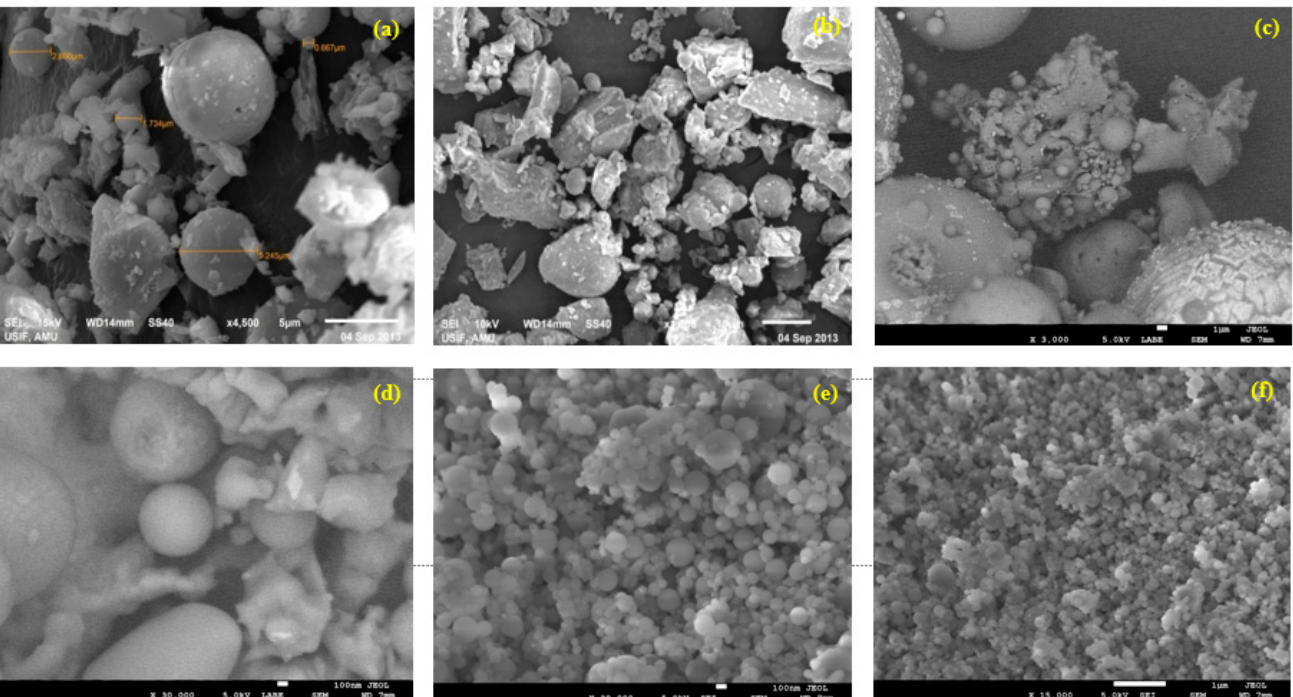
Figure 4. SEM images of ( a ) normal cement, ( b ) converted nano-cement, ( c ) fly ash, ( d ) nano-fly ash, ( e ) silica fume, and ( f ) nano-silica fume.